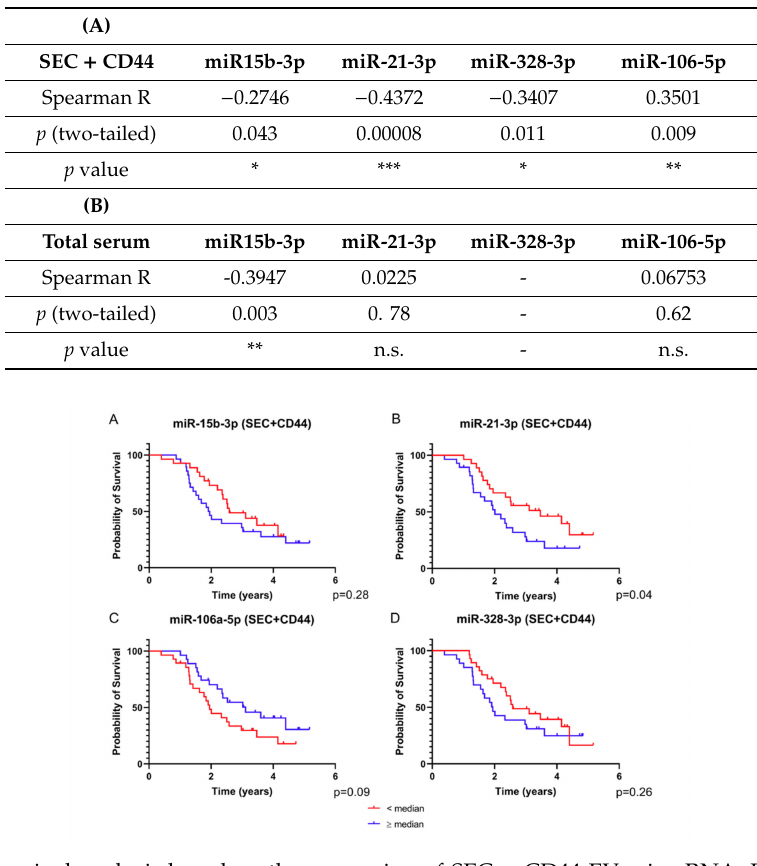
Figure 4. Survival analysis based on the expression of SEC + CD44 EV microRNA. Depicted are survival curves using a dichotomous assessment based on microRNA levels of SEC + CD44 EVs. (( A ) miR-15b-3p, ( B ) miR-21-3p, ( C ) miR-106a-5p, ( D ) miR-328-3p) from glioblastoma patient serum ( n = 55). Red color indicates patients with values equal to or higher than the median and blue color represents values lower than the median normalized expression ratio. Note that all four microRNAs were able to stratify the patients into di ff erent prognostic subgroups, albeit not reaching statistical significance. The p value for miR-21-3p is above the critical Benjamini–Hochberg value (0.03, Tables S3 and S4). Also note that for miR-106a-5p, higher values correlate with a better